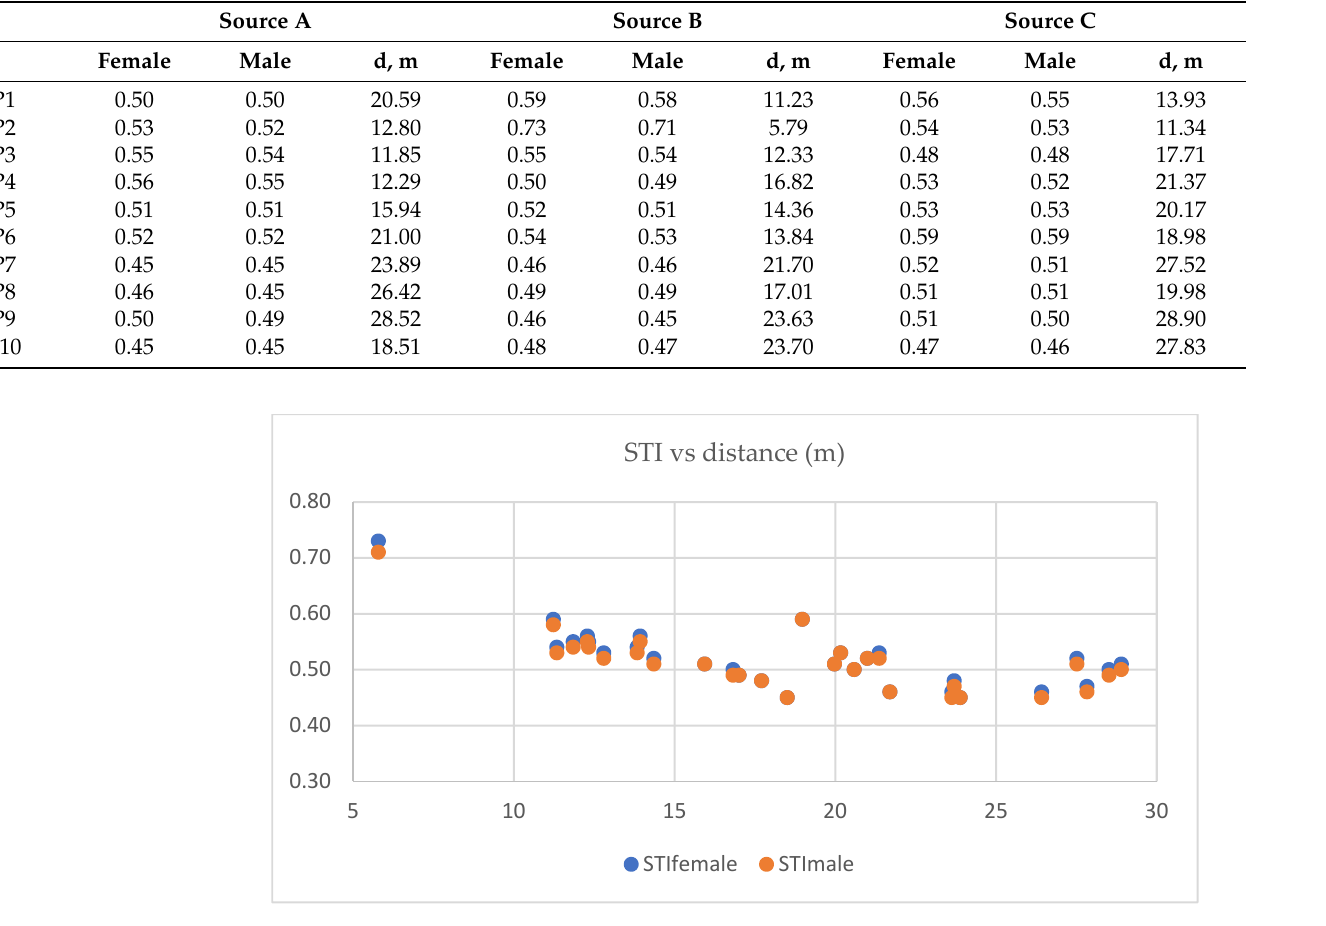
Figure 10. Speech transmission index vs. source–receiver distance (m). Table 9. STI values for source/receiver combinations.